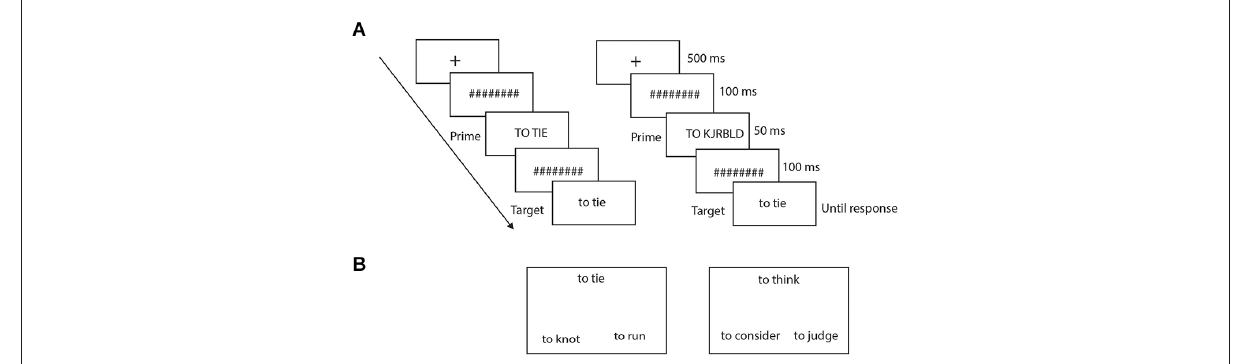
of stimuli preceded with identity vs. random primes. The